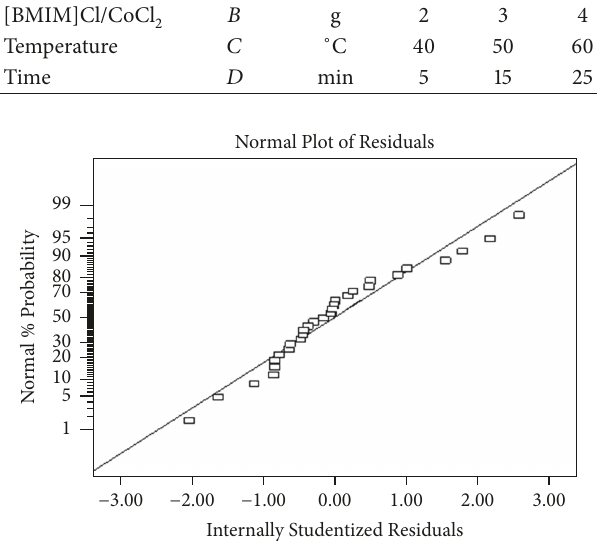
Figure 1: Normal probability of